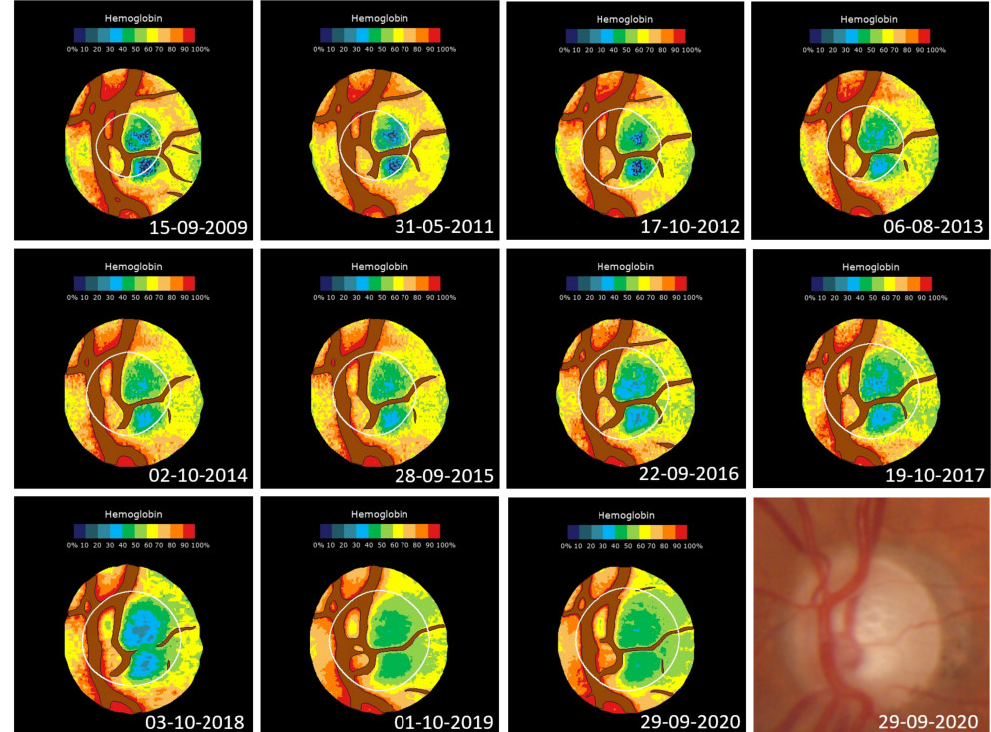
Figure 5. Changes in the haemoglobin distribution in a 1.74 mm 2 optic nerve of a diabetic patient with associated glaucoma. From 2009 to 2020, the GIP index decreased from an initial value of 43.2 to −42.5 (r = 0.94; p < 0.0001) and the cup went from occupying 20.0% of the disc to 53.1% ( p = 0.97; p < 0.0001). The GDF index goes from an initial borderline situation (−0.49) to clearly anomalous (−52.0). Boom right: last original image.